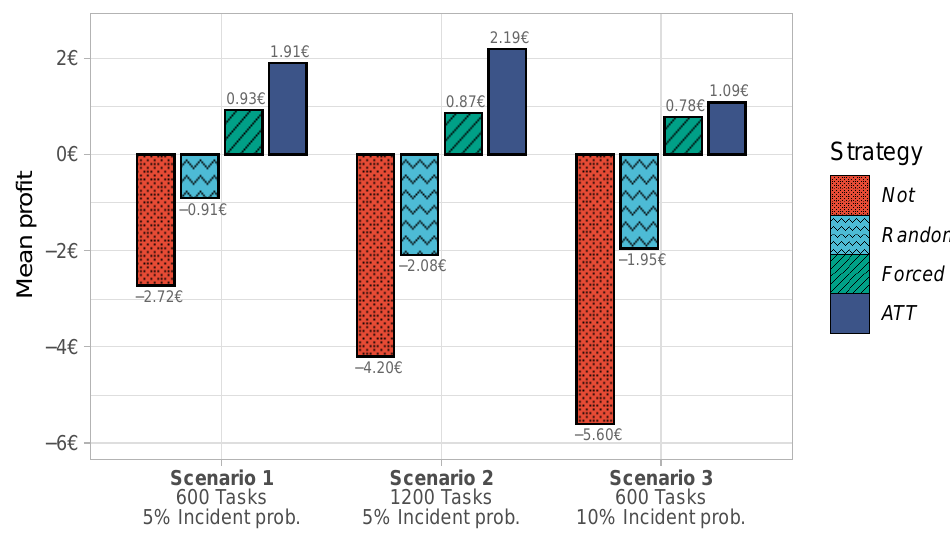
Figure 5. The observed profits under four strategies in three crowdsensing